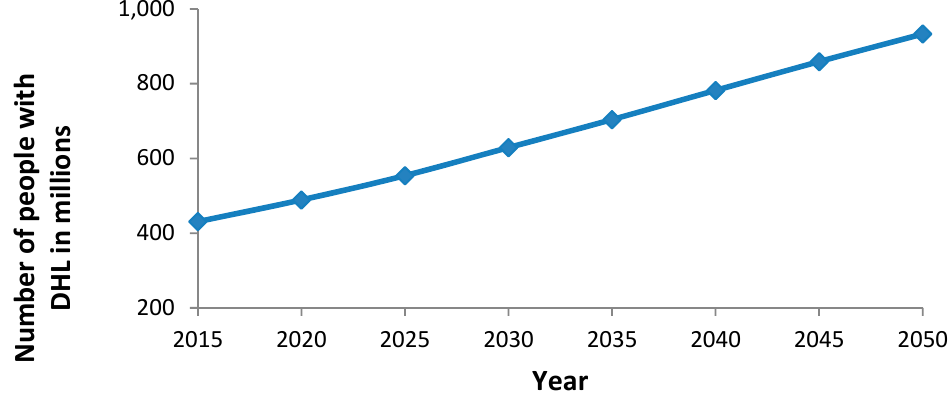
Figure 1. Global increase (estimated and projected) of number of people with disabling hearing loss (modified according to [1]).